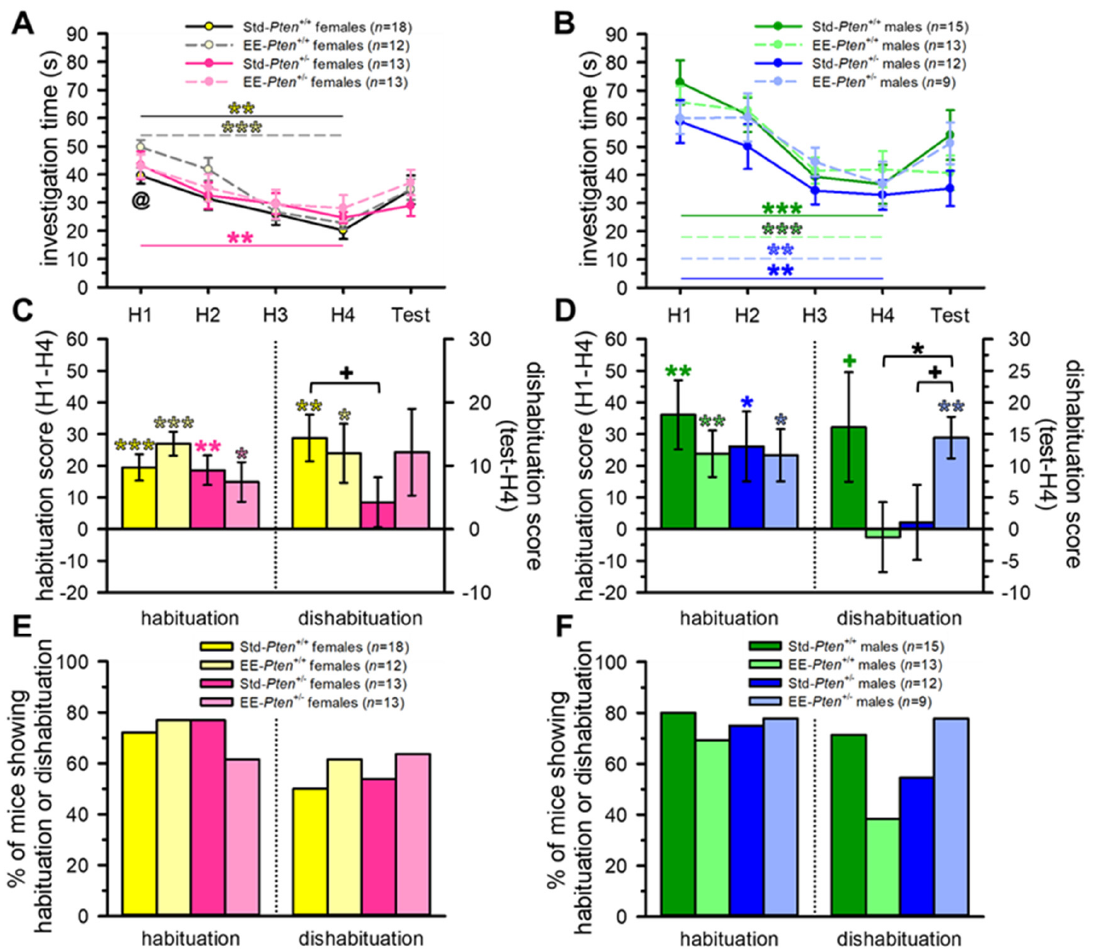
Figure 3. Environmental enrichment rescues social recognition deficits in Pten +/ − male mice. ( A , B ) All female ( A ) and male ( B ) groups except EE- Pten +/ − females showed a significant reduction in investigation across trials from H1 to H4. EE- Pten +/ − females also investigated less than female EE- Pten +/+ controls ( A ). ( C , D ) Female ( C ) and male ( D ) mice in all groups habituated. Std- Pten +/+ and EE- Pten +/+ , but not Std- Pten +/ − or EE- Pten +/ − , females dishabituated, with a trend to a lower dishabituation score in Std- Pten +/ − than Std- Pten +/+ females ( C ). Std- Pten +/+ , but not EE- Pten +/+ , males and EE- Pten +/- , but not Std- Pten +/ − , males dishabituated, with a genotype difference in EE mice, and an effect of enrichment on Pten +/ − mice ( D ). ( E–F ) Percent of female ( E ) and male ( F ) mice tested that showed habituation or dishabituation. Mean ± SEM. Black symbols, difference between genotypes or conditions. Colored symbols, effect of trial (one-way ANOVA; ( A,B )) or difference from 0 (one-sample t-test; ( C , D )). @ Difference between EE- Pten +/+ and EE- Pten +/ − females, p < 0.05. *** p < 0.001, ** p < 0.01, * p < 0.05, + p < 0.10. H1–H4, habituation trials 1–4; Std, standard housing; EE, environmental enrichment.